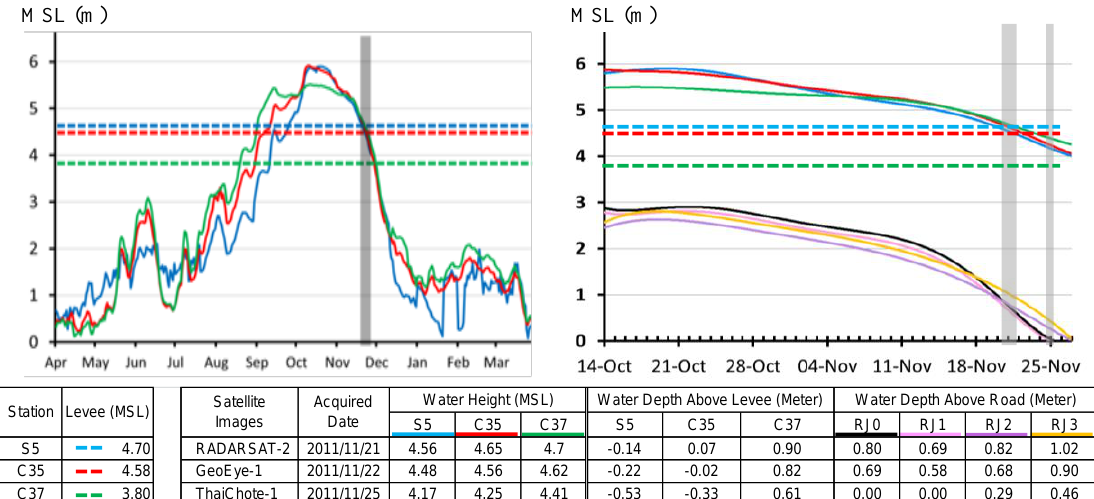
Figure 10. Comparison of the water heights recorded at three telemetry gaging stations and the levee heights ( left ); enlargement of the left plot for 14–27 October and the water depths above the road surface observed at four checkpoints in the Rojana Industrial Park ( right ).